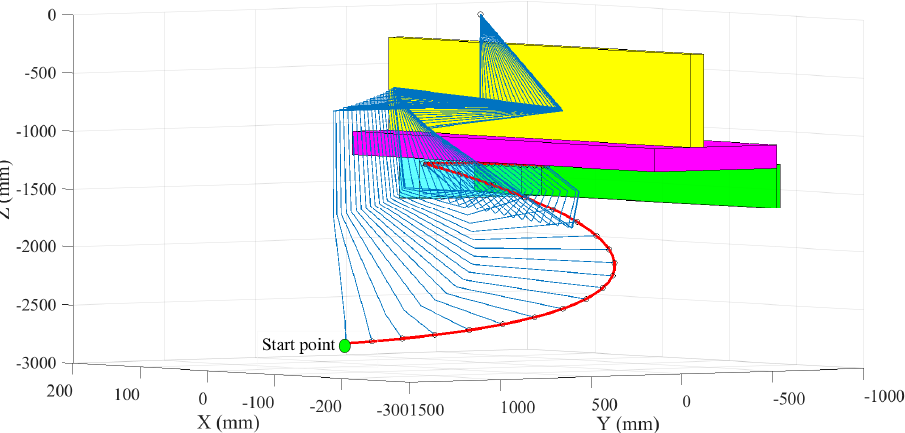
Figure 21. Schematic diagram of the motion of the manipulator.